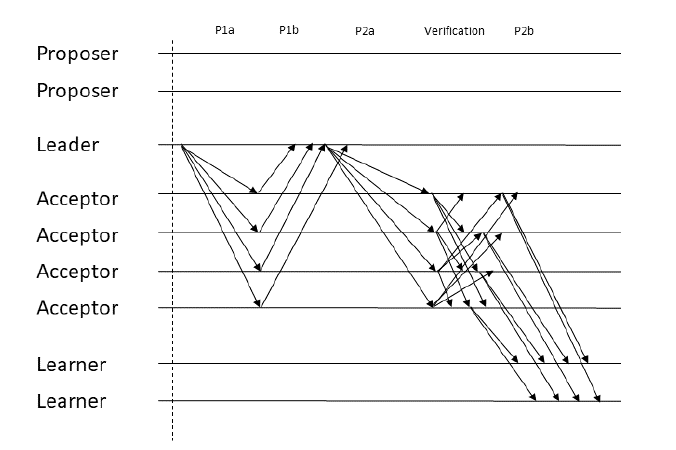
Figure 2. BGP’s classic ballot message pattern.